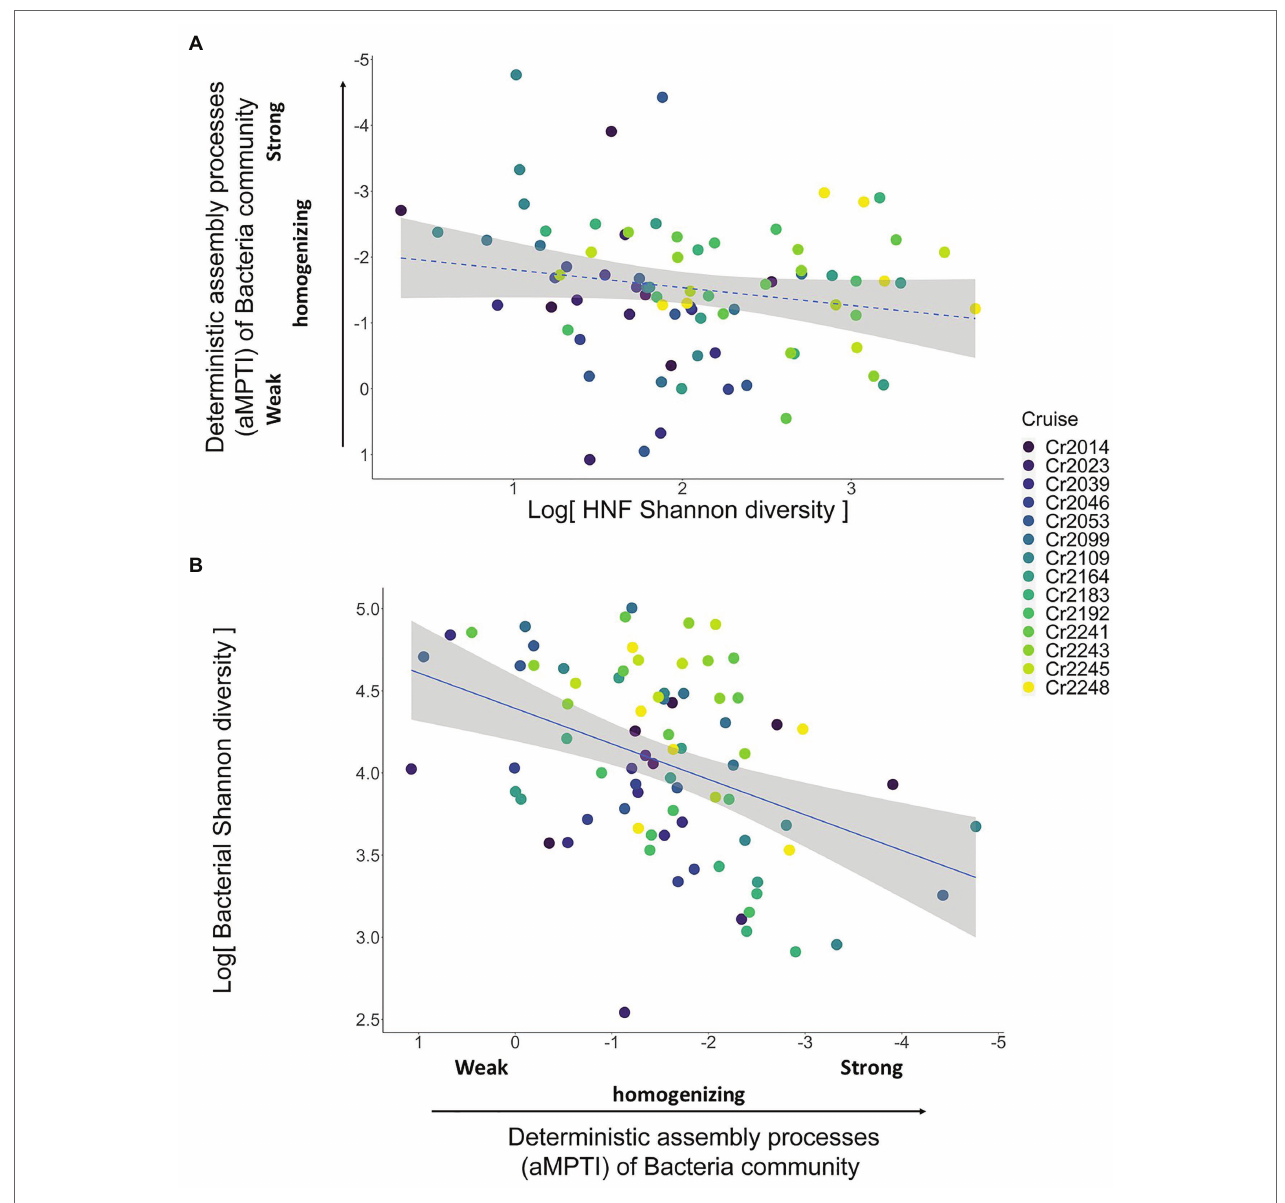
FIGURE 3 | Scatterplots showing the test for top-down control mechanisms. Panel (A) shows the non-significant relationship with p = 0.1 (dashed blue line) between HNF Shannon diversity and the deterministic assembly processes ( α MPTI ) of bacteria community. This relationship becomes significant after including other environmental variables ( Table 1 ). Panel (B) shows the significant relationship (solid blue line) between the α MPTI of bacteria community and the Shannon diversity of bacteria. Including other environmental variables does not qualitatively alter this result ( Table 1 ). The p -value and R 2 are derived from univariate GLMM. Note that the α MPTI of bacteria are mostly negative, so that, we reversed the y axis of panel (A) and x axis in panel (B) for visual intuition. The gray shaded area around the blue line indicates the 95% confidence interval of the regression line (GLMM). The colors of dots represent different sampling cruises.